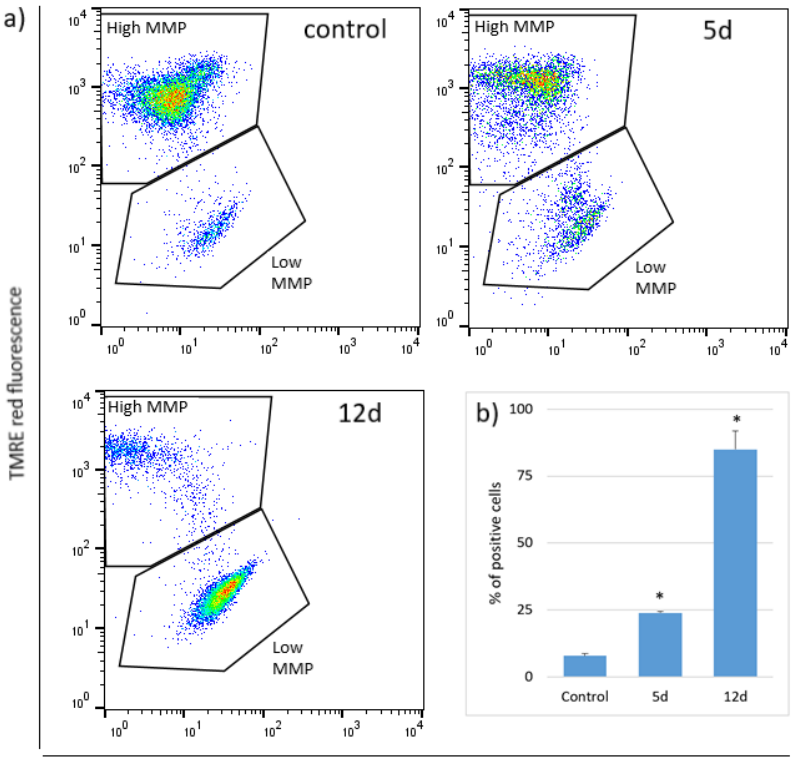
Figure 4. Detection of changes in the mitochondrial membrane potential ( ∆Ψ m) in HuT78 cells after 24 h treatment with 5 µ mol dm − 3 5d and 12d . Control cells were non-treated cells. ( a ) Changes in the ( ∆Ψ m) were measured using TMRE (tetramethylrhodamine, ethyl ester, and perchlorate) dye. Positive control cells were treated with 20 µ M FCCP (carbonyl cyanide-p-trifluoromethoxyphenylhydrazone). ( b ) Quantitative data are reported as average value ± SD. An asterisk (*) denotes values statistically significantly different when compared to the control ( p <